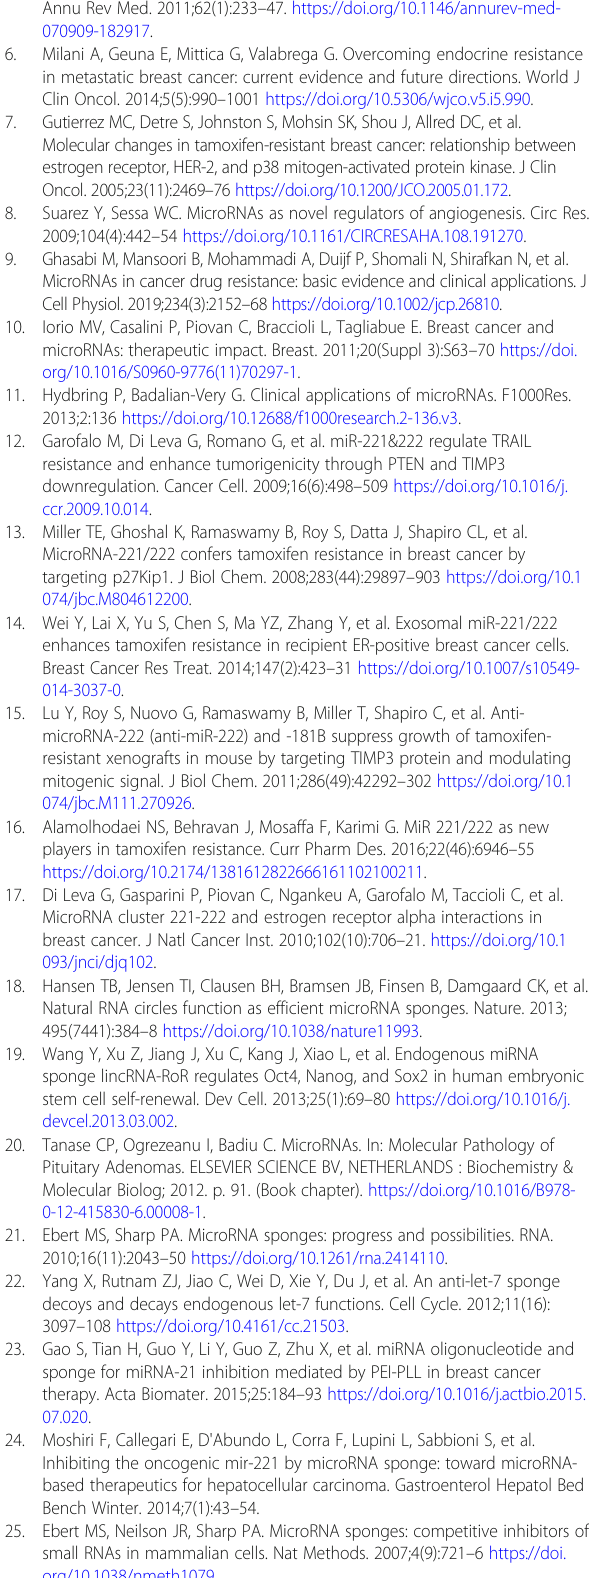
blotting. Supplementary Table 3. Sequence of miR-221/222 sponge. Supplementary Table 4. Sequence of primers. Supplementary Figure 1. The morphological changes of MCF-7 TamR cells after the transfection with the miR-221/222 sponge expression